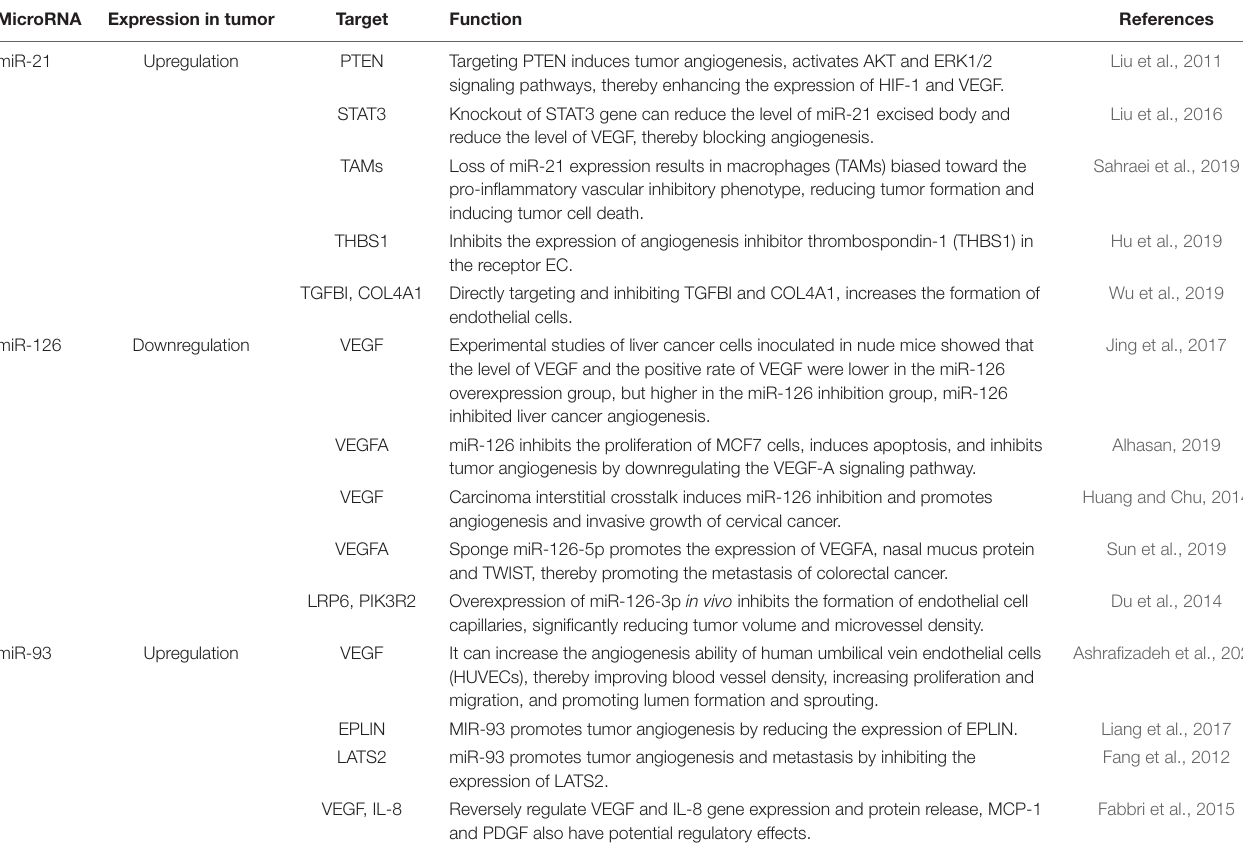
TABLE 1 | Common microRNA targets and functions in regulating tumor